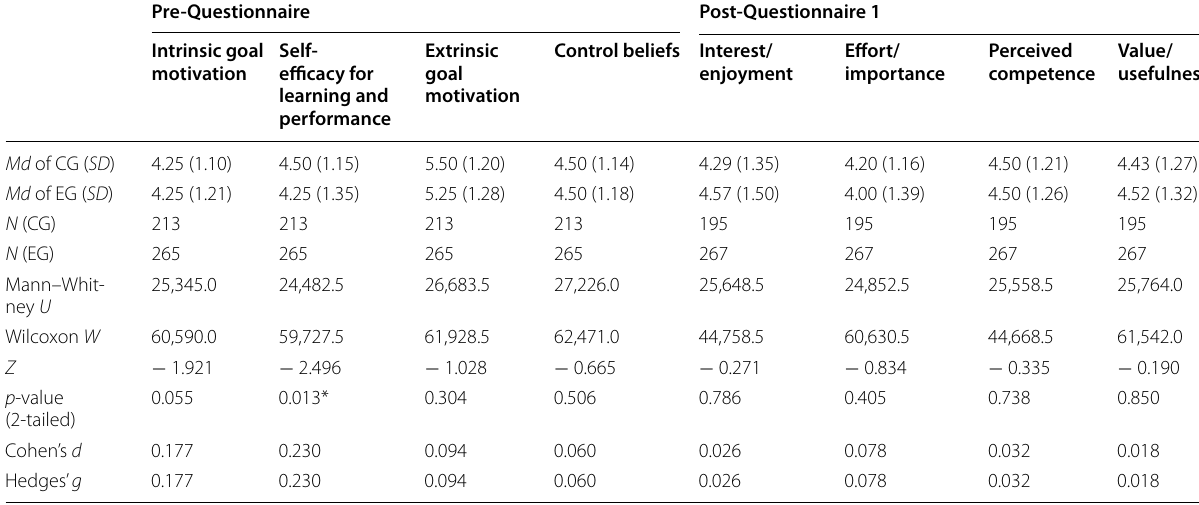
Table 2 Comparison of students’ motivation between the CG and EG regarding control lessons (Pre-Questionnaire and Post- Questionnaire 1) (Mann–Whitney U